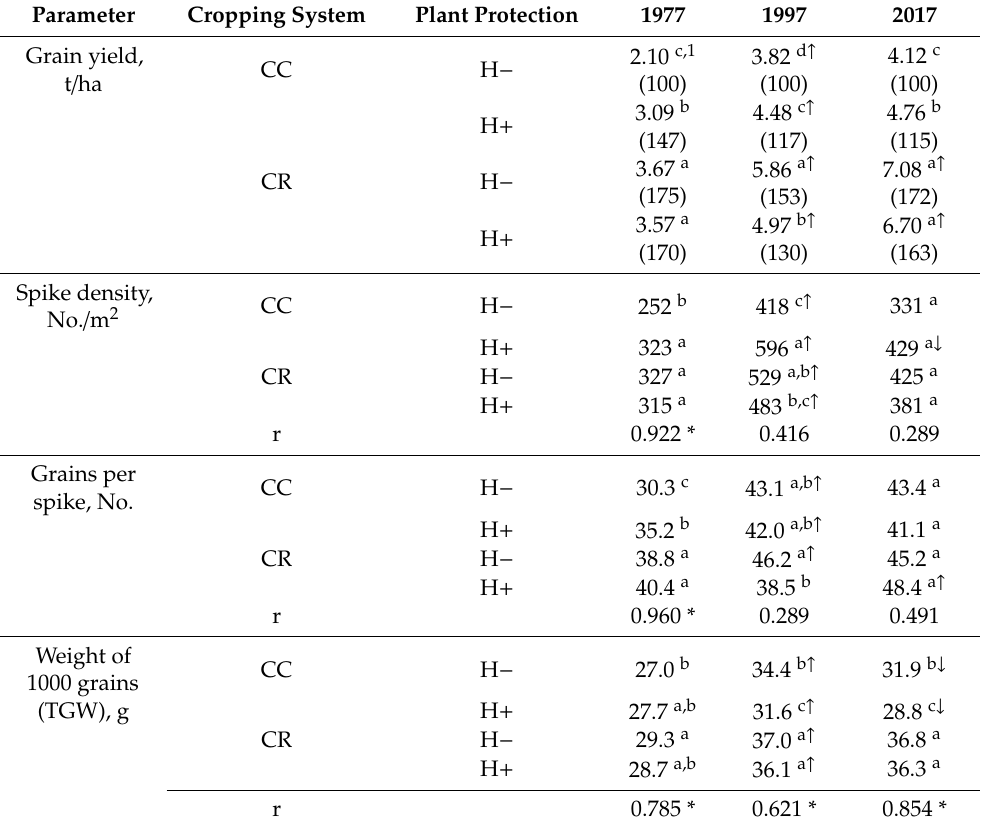
Table 10. Winter rye grain yield and yield components (relative numbers in brackets are % of CC-H − e ff